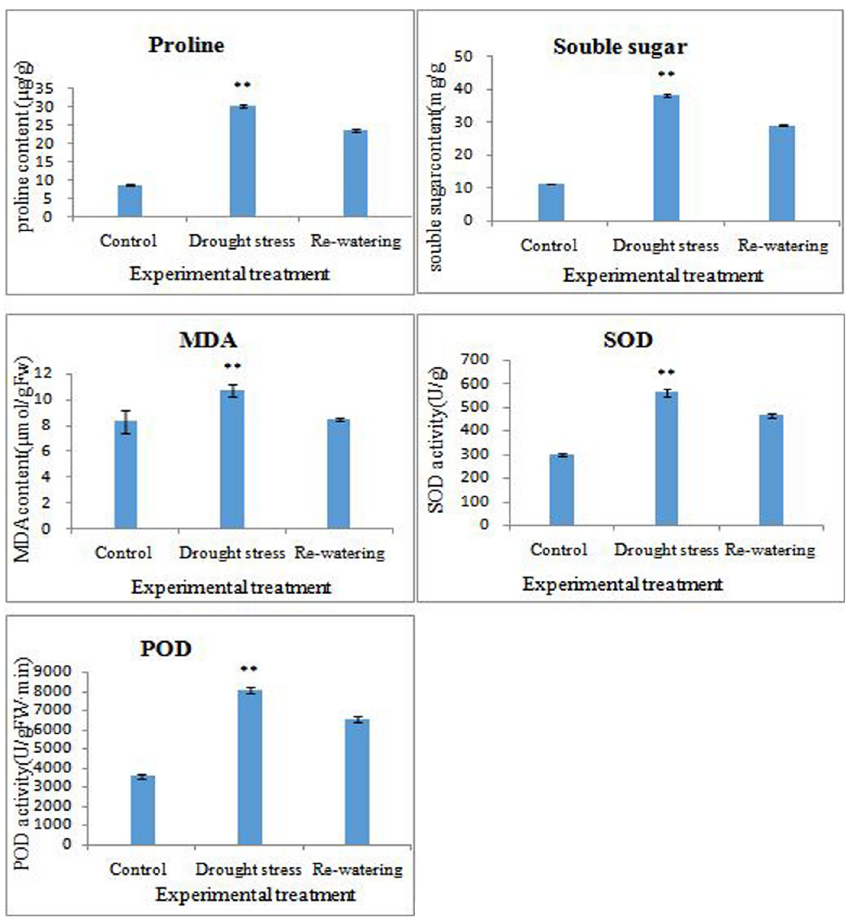
Fig 2. The change of 5 physiological indexes among control, drought stress and re-watering.